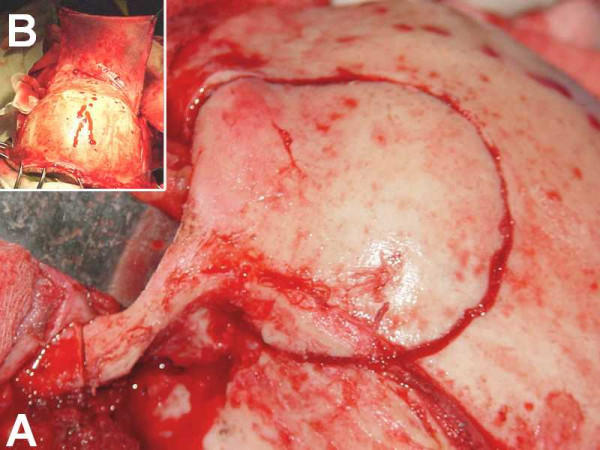
Elevation of pericranial flap and craniotomy. Pericranial flap being raised after elevation of the scalp flap (B) followed by a single burr hole frontoorbitotomy (A).